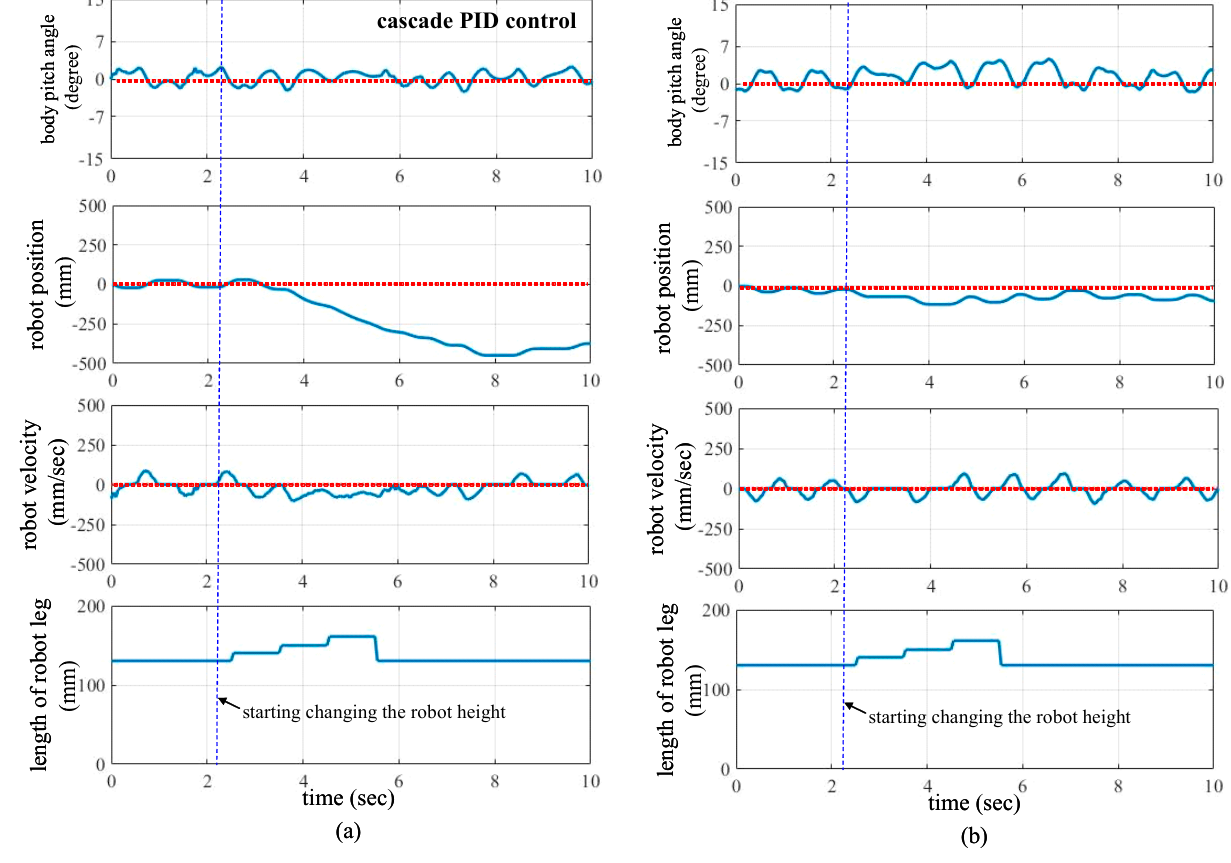
Figure 8. Results of height changing. ( a ) Cascade PID control; ( b ) the IMBC system.